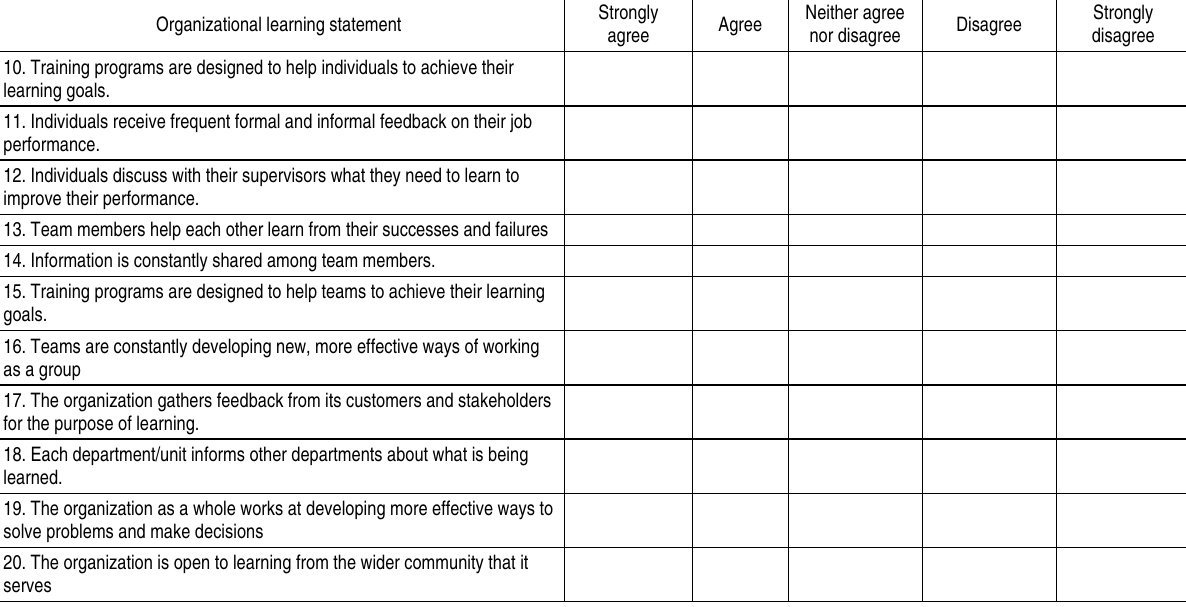
Table 4 (cont.). Organizational learning